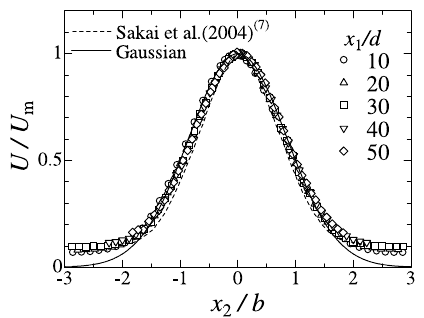
Fig. 12 The cross-streamwise profiles of the mean streamwise